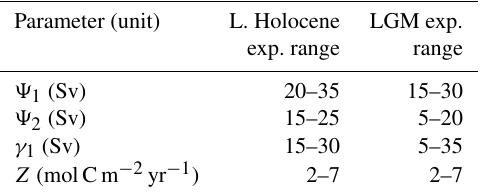
Table 4. Parameter value ranges for the late Holocene and LGM model–data